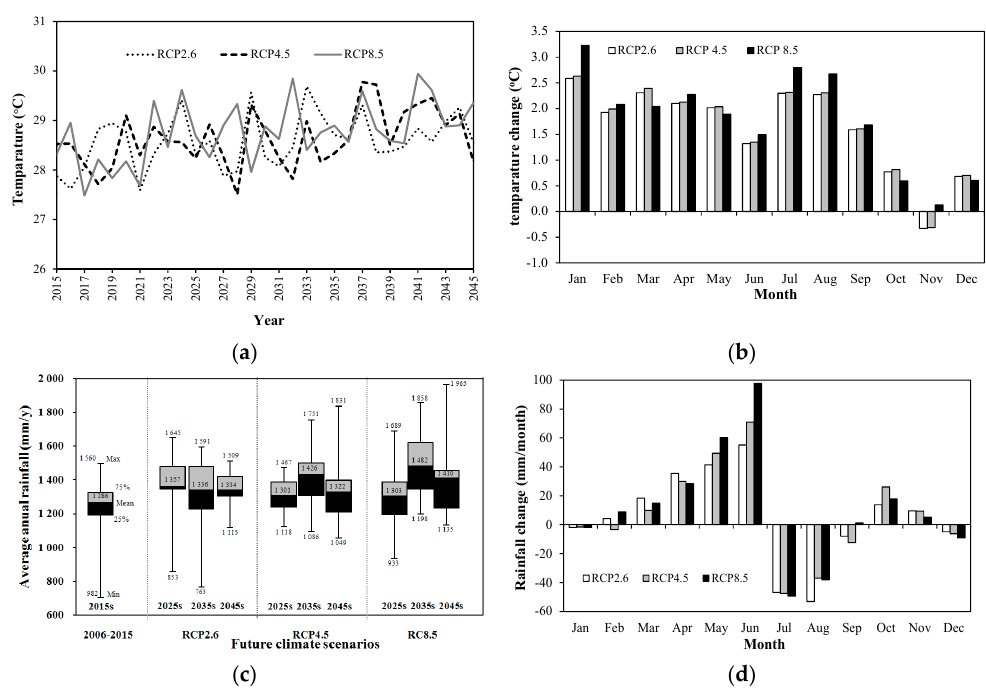
Figure 16. The projected average annual temperature ( a ), changes in monthly temperature from baseline ( b ), average annual rainfall of every 10 years ( c ) and changes in average monthly rainfall ( d ) under three climate scenarios.